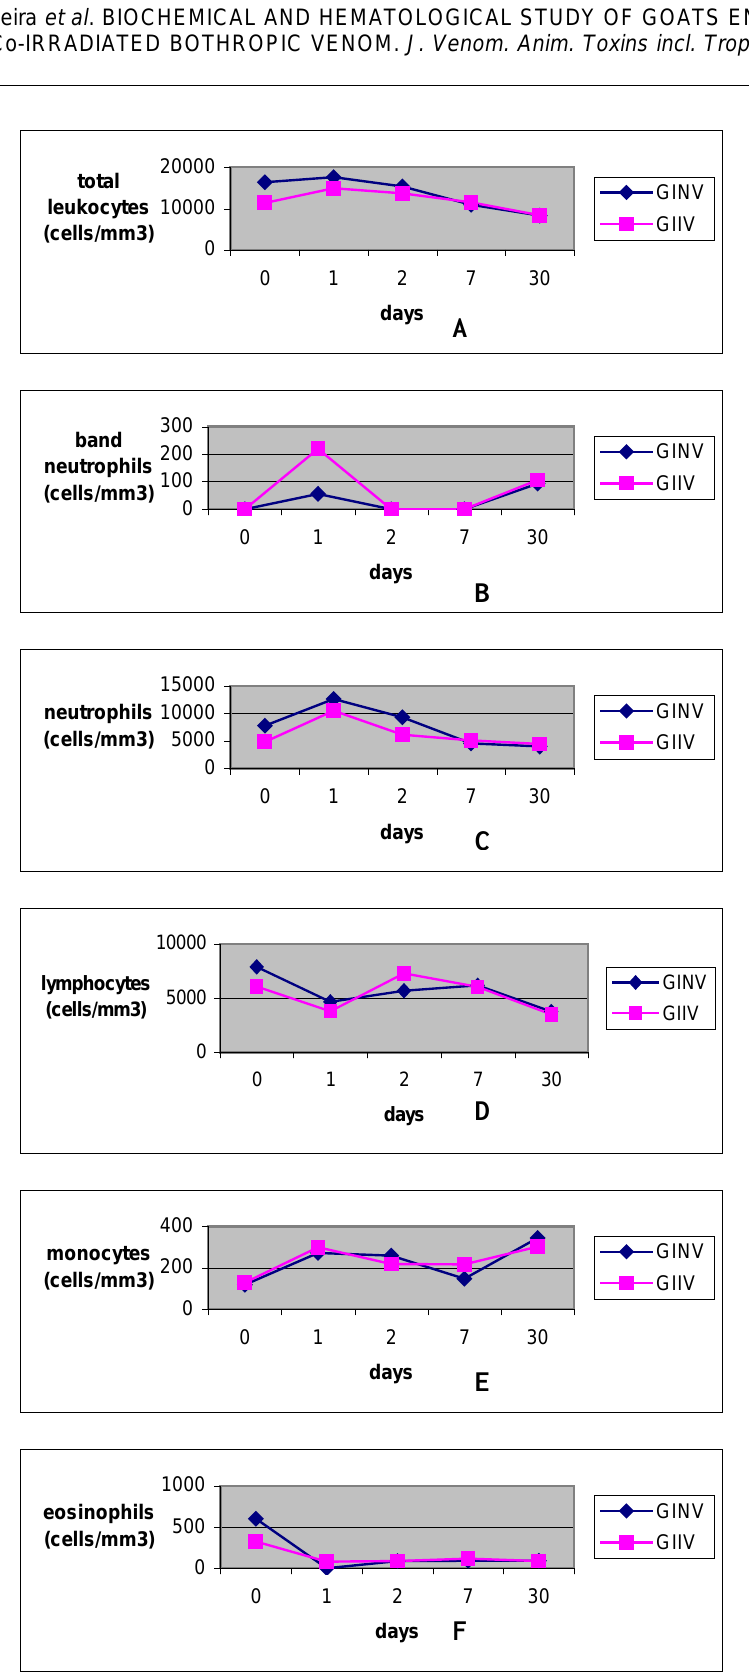
Figure 4. Total and differential leukocyte counts (A: total leukocytes, B: band neutrophils, C: neuthrophils, D: lymphocytes, E: monocytes, F: eosinophils) in total blood of animals of the group inoculated with natural venom (GINV) and the group inoculated with irradiated venom (GIIV) before and after venom